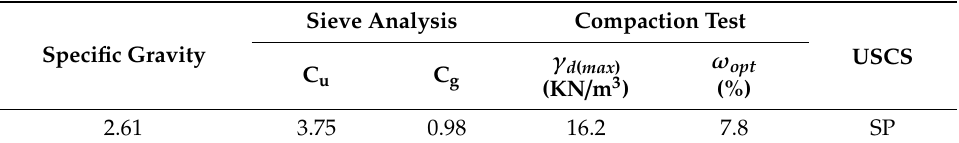
Table 1. Engineering properties of sand.